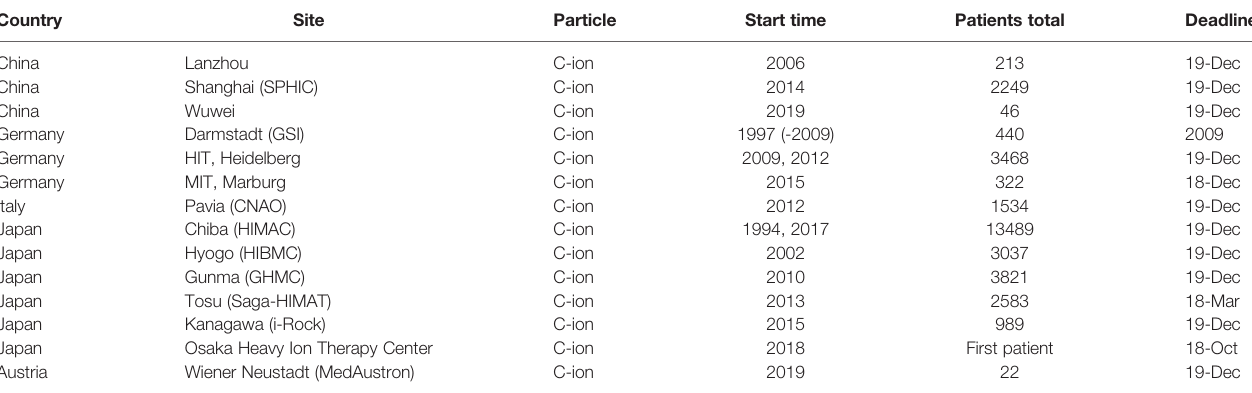
TABLE 1 | Institutions perform carbon ion radiotherapy (update to 2020).